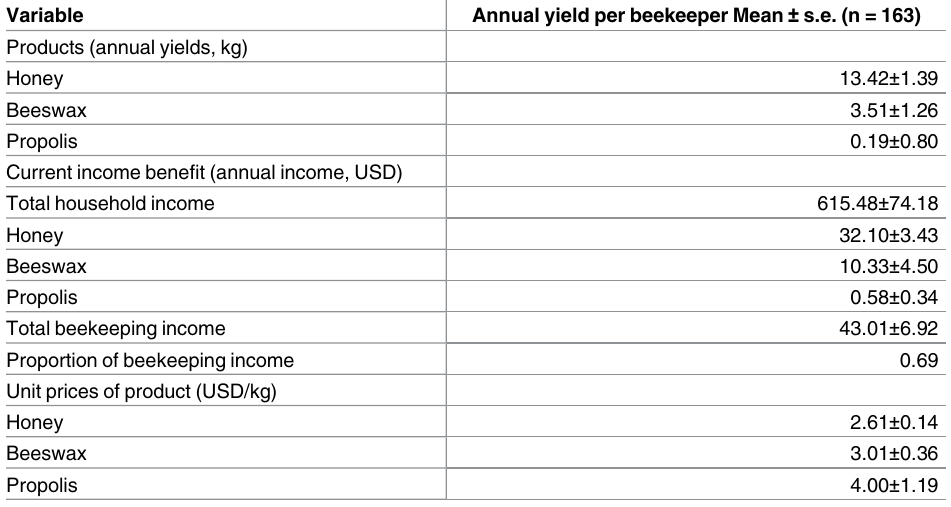
Table 8. Products harvested, current income benefits and unit product prices from